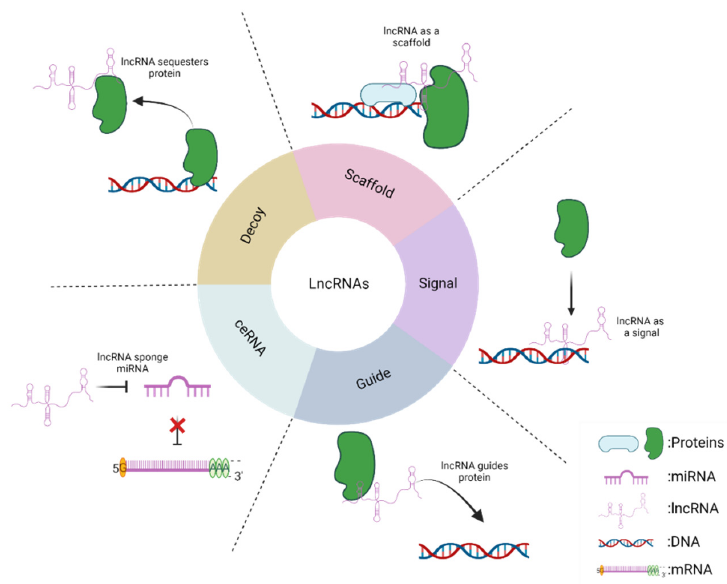
Figure 2. Scheme of the mechanisms of action of lncRNAs. This diagram shows the different forms in which lncRNAs can regulate different molecular processes. Decoy: lncRNA can sequester a protein of interest, interfering with its normal function. Scaffold: lncRNA can interact with different proteins allowing the formation of protein complexes. Signal: lncRNA acts as a tag for the recruitment of a protein to a specific site. Guide: lncRNA drives a protein of interest to its specific site of action. ceRNA: lncRNA acts as a competitive molecule that binds a miRNA sequence preventing the binding of this miRNA to its target (mRNA), allowing that the mRNA increases its stability and